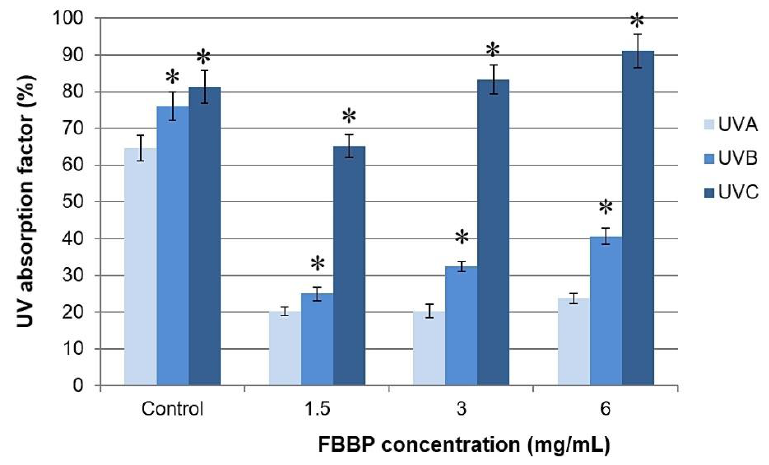
Figure 2. UV absorption factor of fish bone bioactive peptides (FBBP) preparation isolated from H. molitrix and commercial SPF6 lotion (control) in UVA, UVB and UVC domain, at different concen- trations. The values were reported as percentage and expressed as mean ± SD ( n = 3). * p < 0.05, compared to UVA.